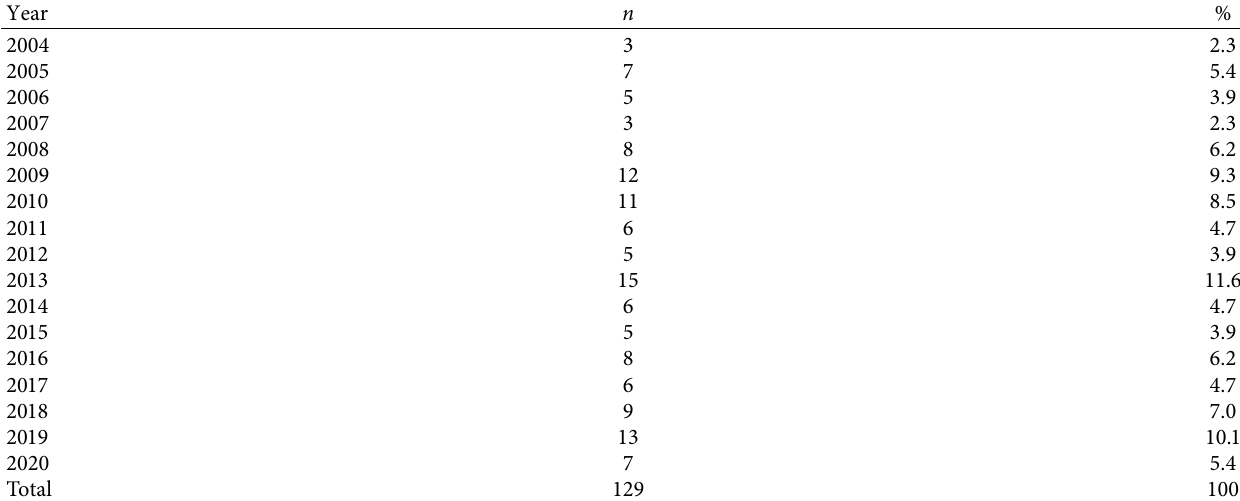
Table 4: Study characteristics: year of publication.